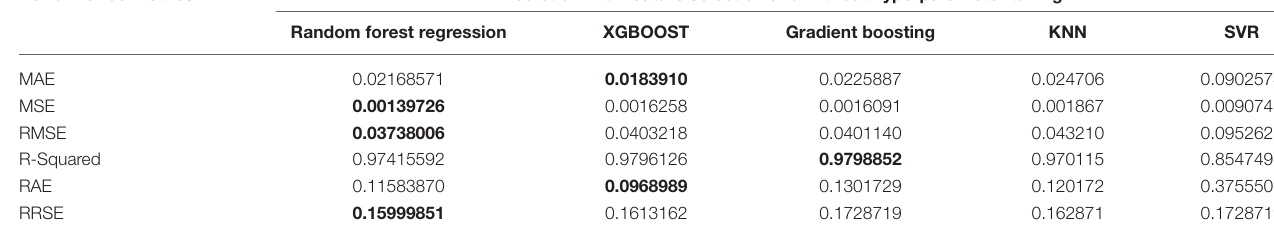
TABLE 3 | Prediction with Feature Selection and without hyperparameter tuning. Performance metrics